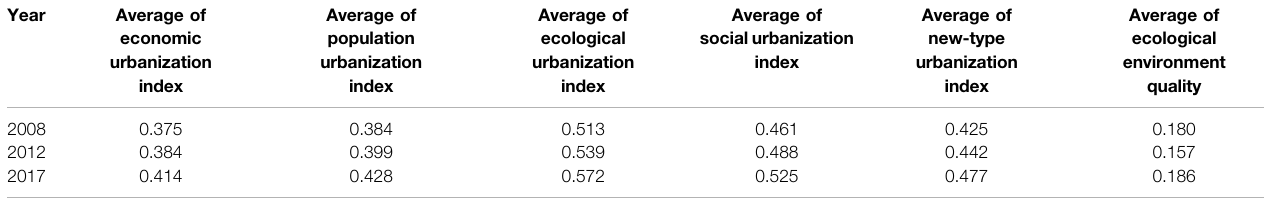
TABLE 3 | The dynamics comparison results of urbanization in 2008 – 2017.